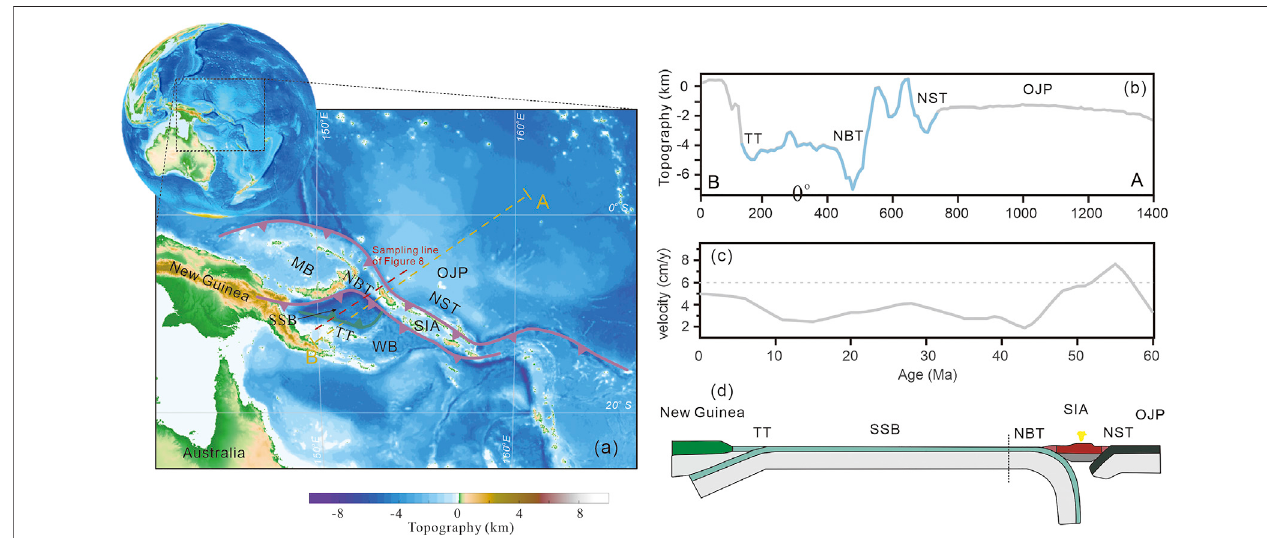
FIGURE1| MapofthePapuaNew Guinearegion. (A) MapoftheNewGuinearegionmodi fi edfromETOPO1.Thepurplelinerepresentsactiveorpotentiallyactive subduction zones and the green line represents dead subduction zones. (B) Topographic pro fi le from ETOPO1. The sampling points are shown by orange lines in Figure.1a. (C) Convergence rate from Müller et al., 2019. (D) Conceptual schemes from Baldwin et al., 2012. NBT: the New Britain Trench; TT: Trobriand Trough; NST: North Solomon Trench. MB: Manus Basin; OJP: Ontong – Java Plateau; SIA: Solomon Island Arc; WB: Woodlark Basin.